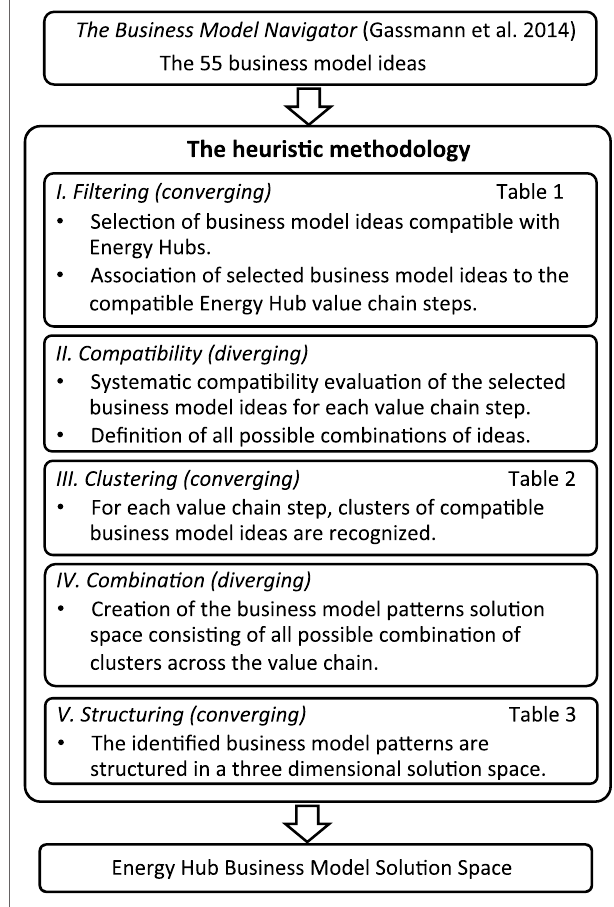
FigUre 2 | The heuristic methodology